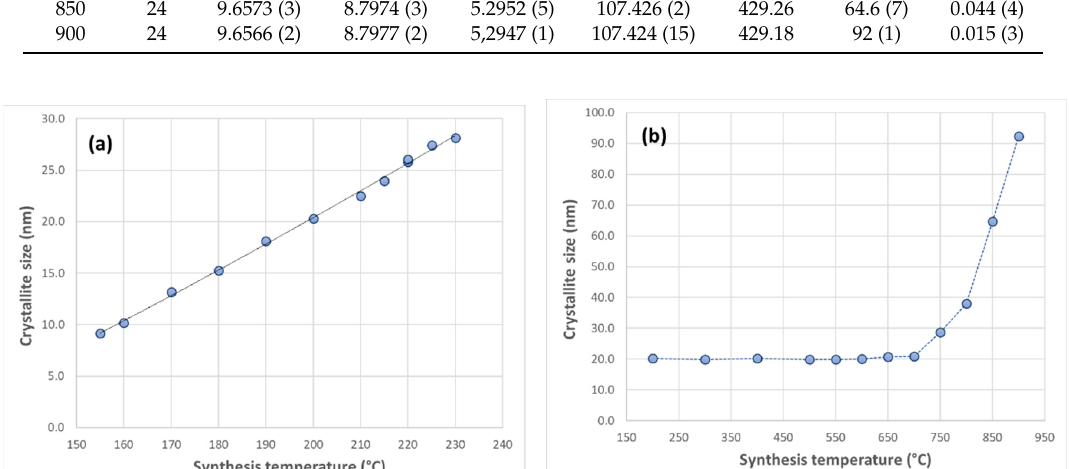
Figure 4. Variation of crystallite size (based on the volume-based integral breath) for aegirine, obtained ( a ) from the 24 h experiments at different temperatures and ( b ) for the tempering series, done on the 200 °C sample at different temperatures between 300 °C and 900 °C. Table 1. Unit cell dimensions, crystallite size and microstrain as determined from Rietveld analysis of powder X-ray diffraction data of aegirine NaFeSi 2 O 6 , synthesized at different temperatures T and holding times d , and for sample material of the 200 °C/24 h experiment, sintered at different temperatures for 24 h each. IB is the crystallite size, obtained from the integral breath of the peaks.